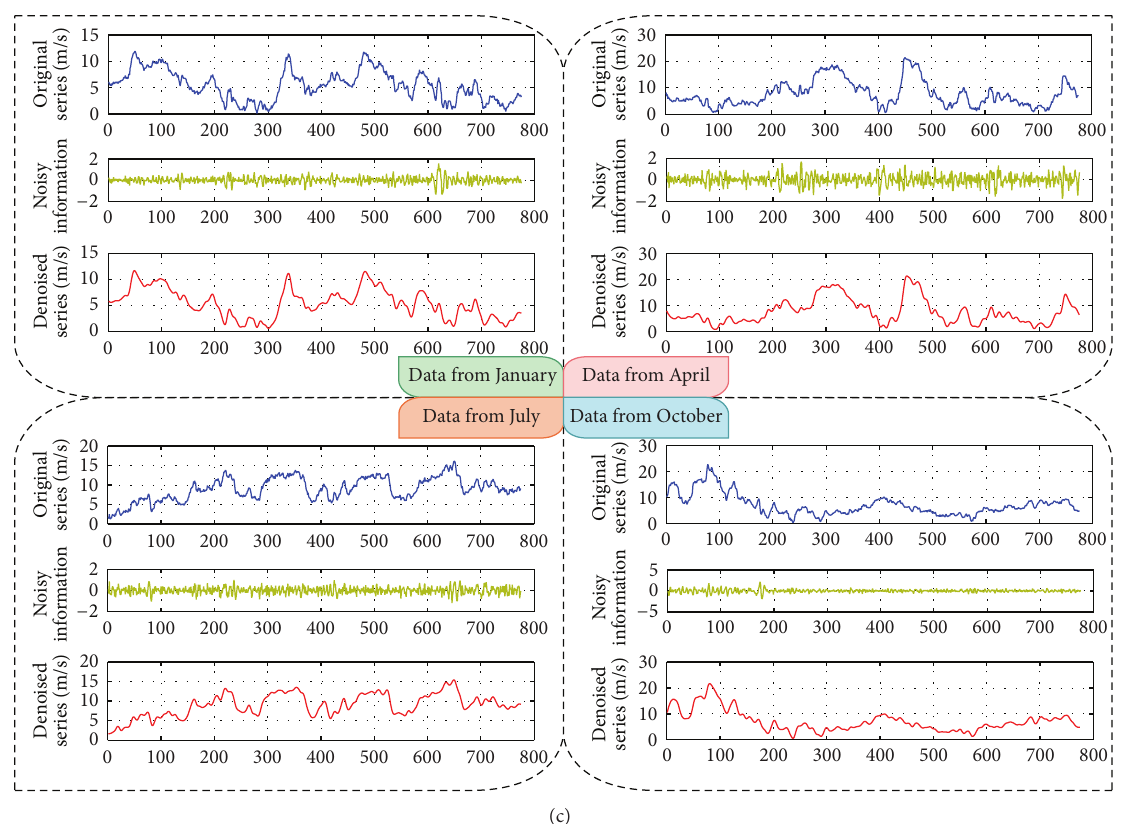
Figure 6: (a) Results of EEMD-based decomposition and denoising at Station 1. (b) Results of EEMD-based decomposition and denoising at Station 2. (c) Results of EEMD-based decomposition and denoising at Station 3.